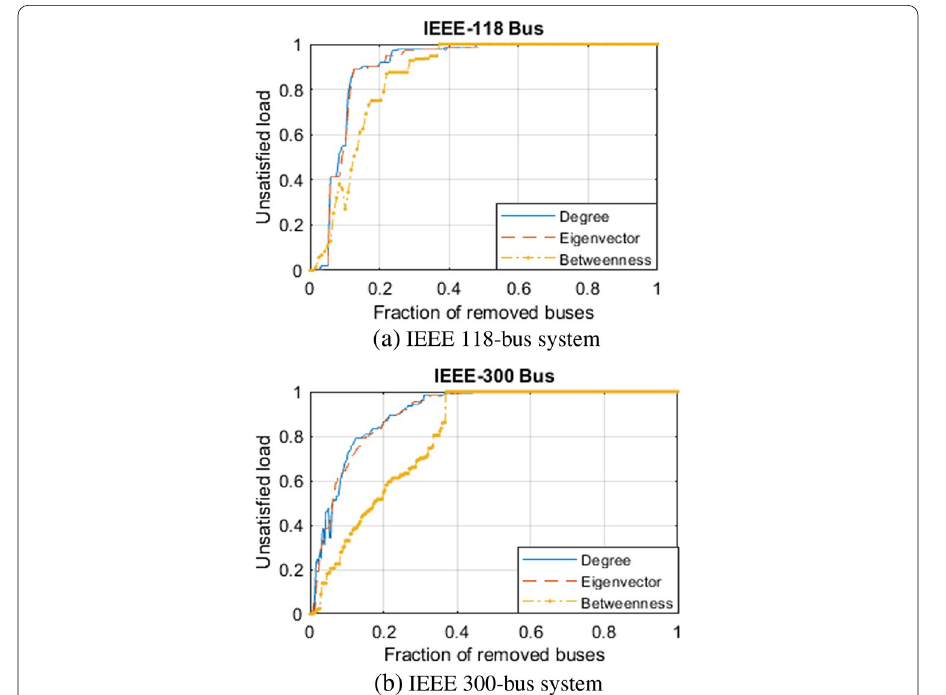
Fig. 6 Vulnerability curves for the IMCE fault profile based on PTM centralities and fraction of removed elements (FOE)